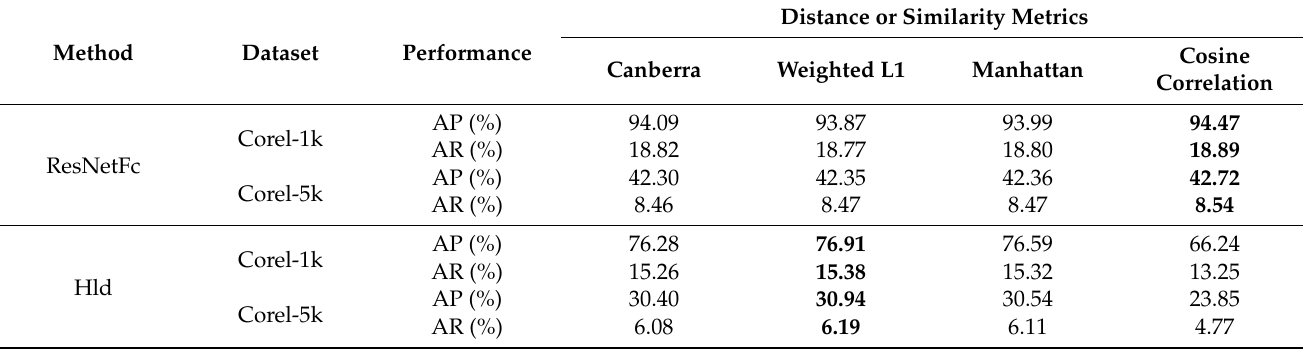
Table 3. APs and ARs results using different methods with different distance or similarity metrics, Top NR = 20.